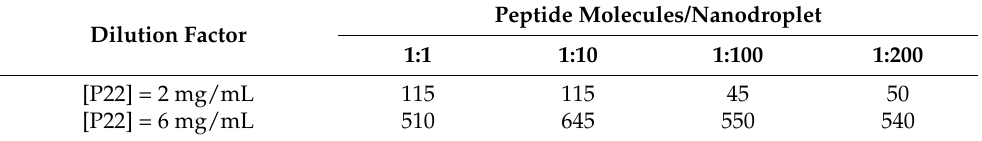
Table 6. Adsorption stability of Tg-NEs/P22 mixture determined with SEC/HPLC before sep- aration under dilution in phosphate buffer (pH 7.2, 60 mM) as a function of the initial peptide 22 concentration.